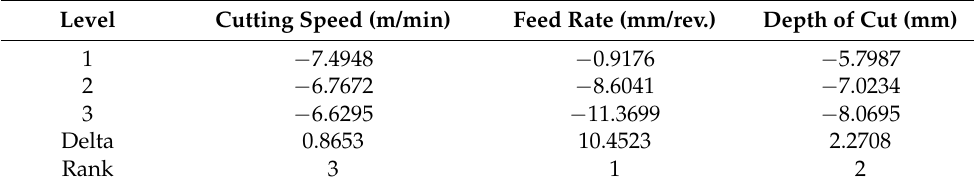
Table 4. Response table for the S/N ratio of surface roughness of the RZ5/8 wt.% TiB 2 composite.